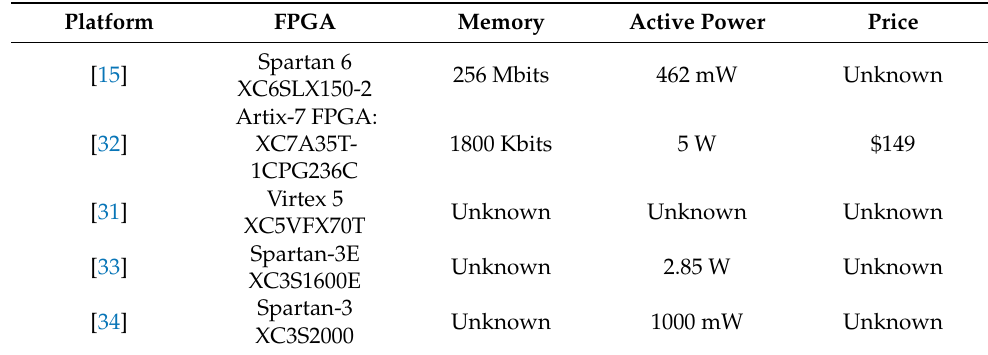
Table 3. FPGA-based